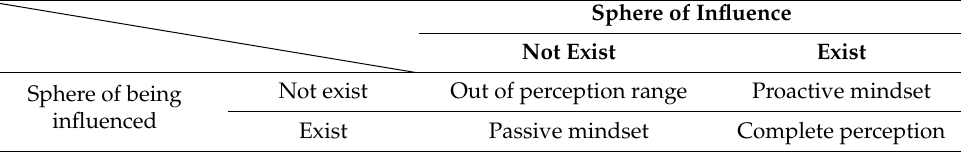
Table 1. Scenarios of perceived influence.